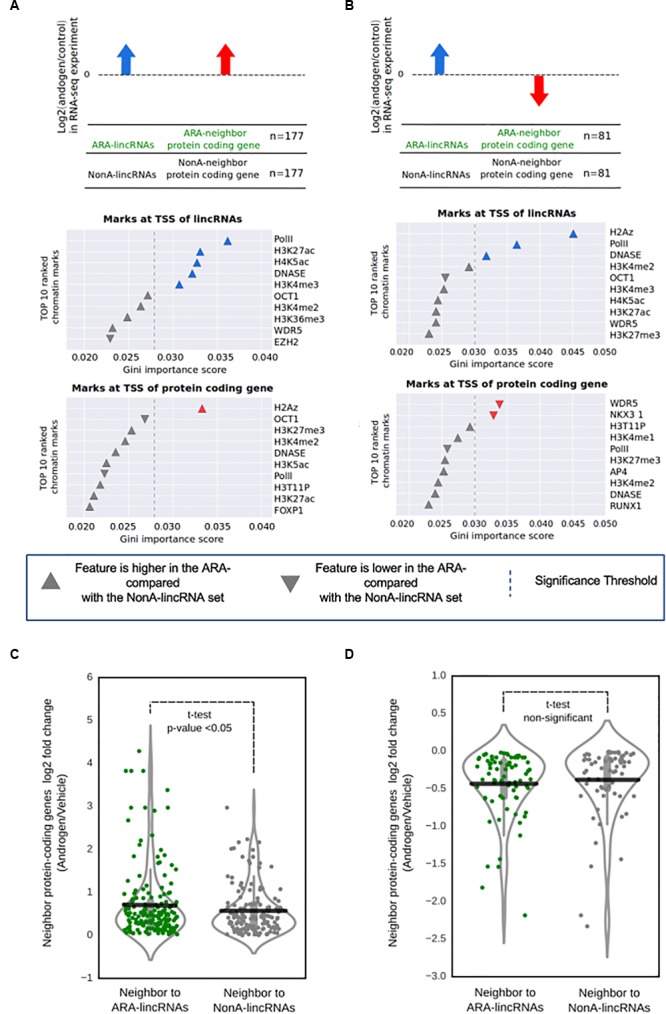
Promoter regions at the ARA-lincRNAs and at the neighbor protein-coding genes exhibit a specific epigenetic signature. (A) Enriched epigenetic marks for the set of ARA-lincRNAs that were neighbors to protein-coding genes whose transcription was activated by androgen. (B) Enriched epigenetic marks for the setof ARA-lincRNAs that were neighbors to protein-coding genes whose transcription was inhibited by androgen. Each panel shows the rank of the top ten most relevant epigenetic marks at the TSS of genes, which were determined by the Random Forest machine learning classifier algorithm to discriminate between ARA-lincRNAs and NonA-lincRNAs; these epigenetic marks were ranked based on their discriminatory potential given by the Gini importance score. Up arrow indicates that the feature is more abundant at the TSS of the ARA-lincRNA (or at the TSS of the protein-coding neighbor) compared with the NonA-lincRNA or the protein-coding neighbor; down arrow indicates that the feature is less abundant at the TSS of the ARA-lincRNA (or at the TSS of the protein-coding neighbor) compared with the NonA-lincRNA or the protein-coding neighbor. Colored arrows indicate that the epigenetic mark enrichment was statistically significant; the statistical significance threshold (dashed line) of the Gini importance score was determined by shuffling the feature vectors between the ARA- and NonA-lincRNAs in a bootstrap procedure (see section “Materials and Methods”). (C) Distribution of the log2 ratio (androgen/vehicle) in the RNA-seq experiment for protein-coding genes with androgen-activated transcription that are neighbors to ARA-lincRNAs (green points, n = 167) compared with protein-coding genes that are neighbors to NonA-lincRNAs (black points, n = 145). All ARA-lincRNAs and NonA-lincRNAs that have a Pol II epigenetic mark at their TSS were included in this analysis. The statistical significance (p < 0.05) of the difference between the average expressions (black horizontal lines) of the two groups was computed using a t-test. (D) Distribution of the log2 ratio (androgen/vehicle) in the RNA-seq experiment for protein-coding genes with androgen-inhibited transcription that are neighbors to ARA-lincRNAs (green points, n = 75) compared with protein-coding genes that are neighbors to NonA-lincRNAs (black points, n = 67). No statistical difference between the average expressions (black horizontal lines) of the two groups was detected.